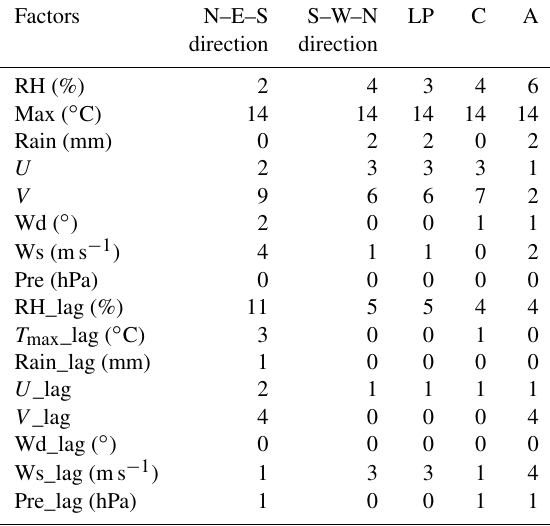
Table 2. All parameters used in the stepwise regression and the number of cities (out of 14) for which each variable was selected for each weather